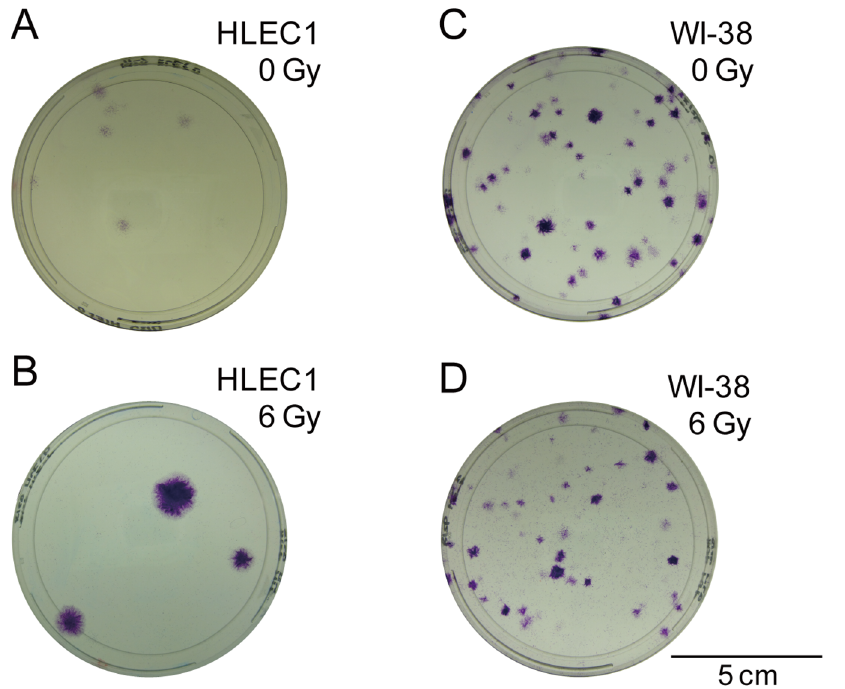
Figure 4. Representative images of colonies arising from sham-irradiated HLEC1 (A), 6 Gy-irradiated HLEC1 (B), sham-irradiated WI- 38 (C), and 6 Gy-irradiated WI-38 (D). Shown are colonies that were formed during 14 days in 10-cm dishes and stained with crystal violet.